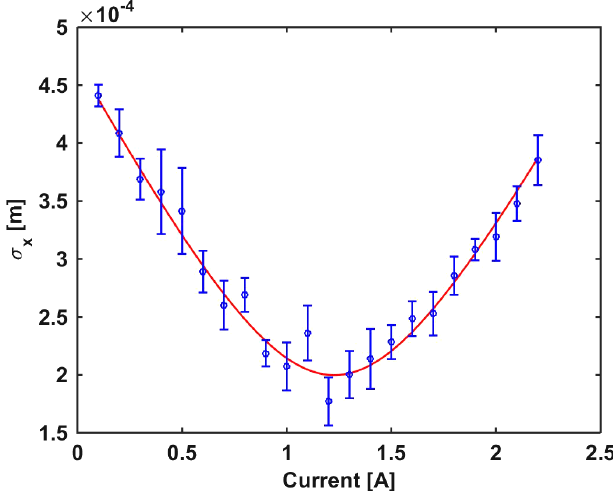
FIG. 7. Train of two drivers and one witness bunch with four different values of quadrupole current. The witness is on the top of the